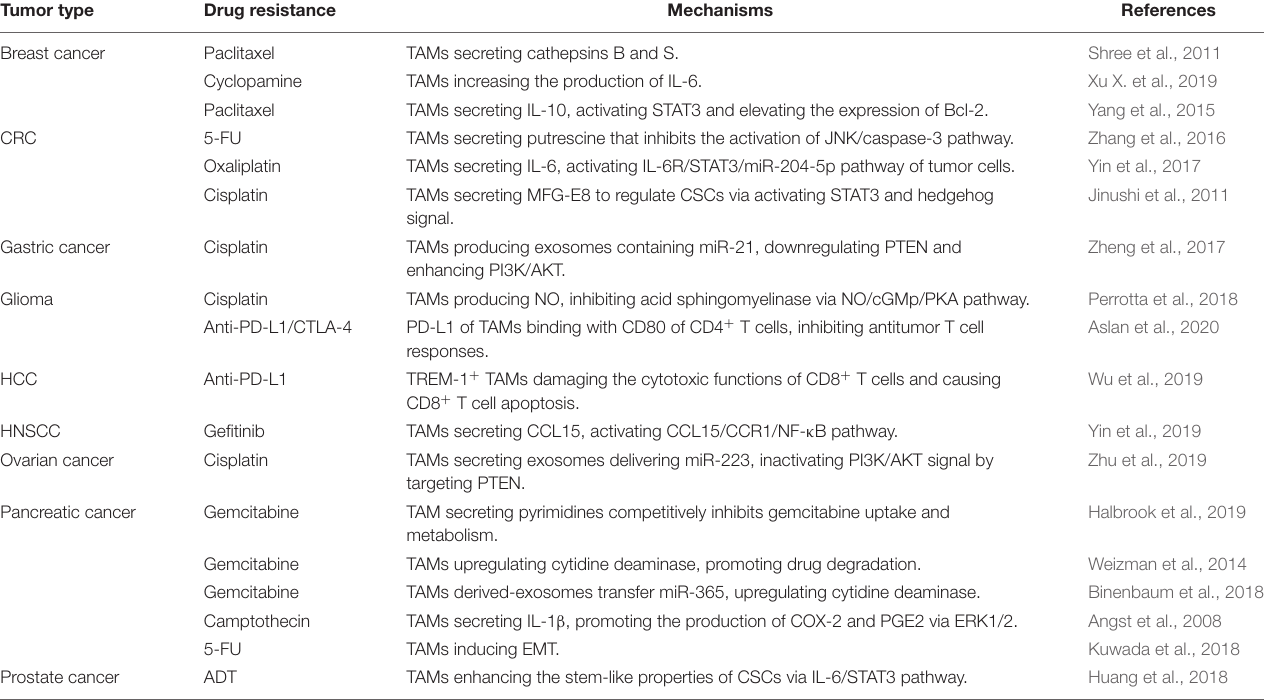
TABLE 2 | Mechanisms of antitumor drug resistance mediated by